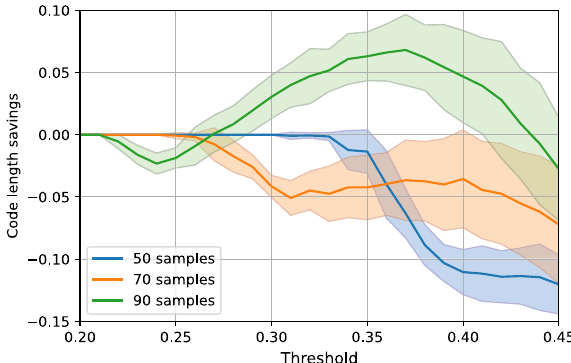
Fig. 3 Code length savings with synthetic data. The code length savings l as a function of the threshold τ for different sample sizes and planted covariance c = 0.3 . With enough samples we get a positive code length saving in the test network, but with fewer samples there is no signal of the modules in the train network. The code length savings are negative when there are spurious modules, or zero when there is only one module. Calculations are averaged over ten runs and the shaded areas show the standard